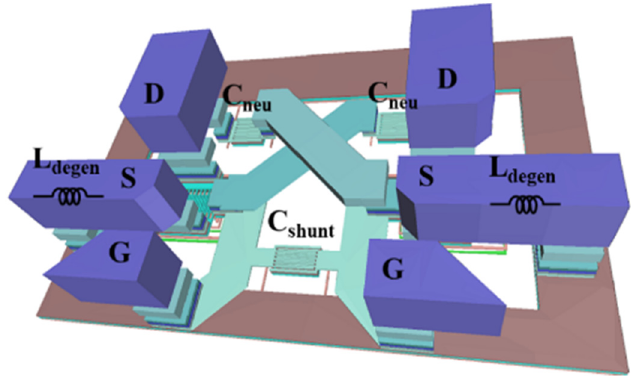
Figure 8. 3D view of the amplifier core.